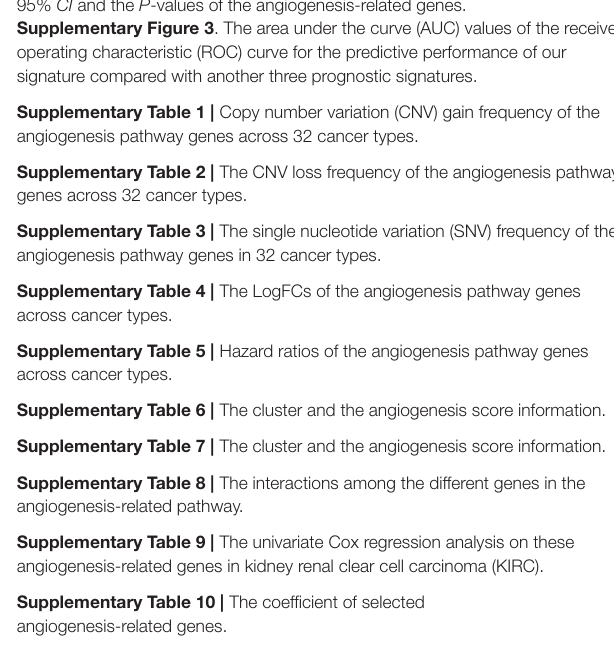
Supplementary Table 4 | The LogFCs of the angiogenesis pathway genes across cancer types. Supplementary Table 5 | Hazard ratios of the angiogenesis pathway genes across cancer types. Supplementary Table 6 | The cluster and the angiogenesis score information. Supplementary Table 7 | The cluster and the angiogenesis score information. Supplementary Table 8 | The interactions among the different genes in the angiogenesis-related pathway. Supplementary Table 9 | The univariate Cox regression analysis on these angiogenesis-related genes in kidney renal clear cell carcinoma (KIRC). Supplementary Table 10 | The coefficient of selected angiogenesis-related